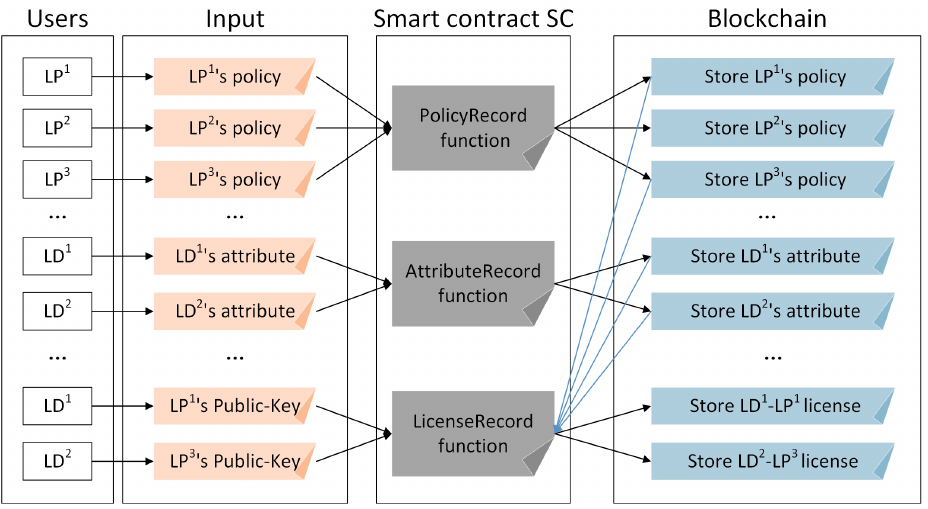
Figure 4. Schematic diagram of SC recording license.